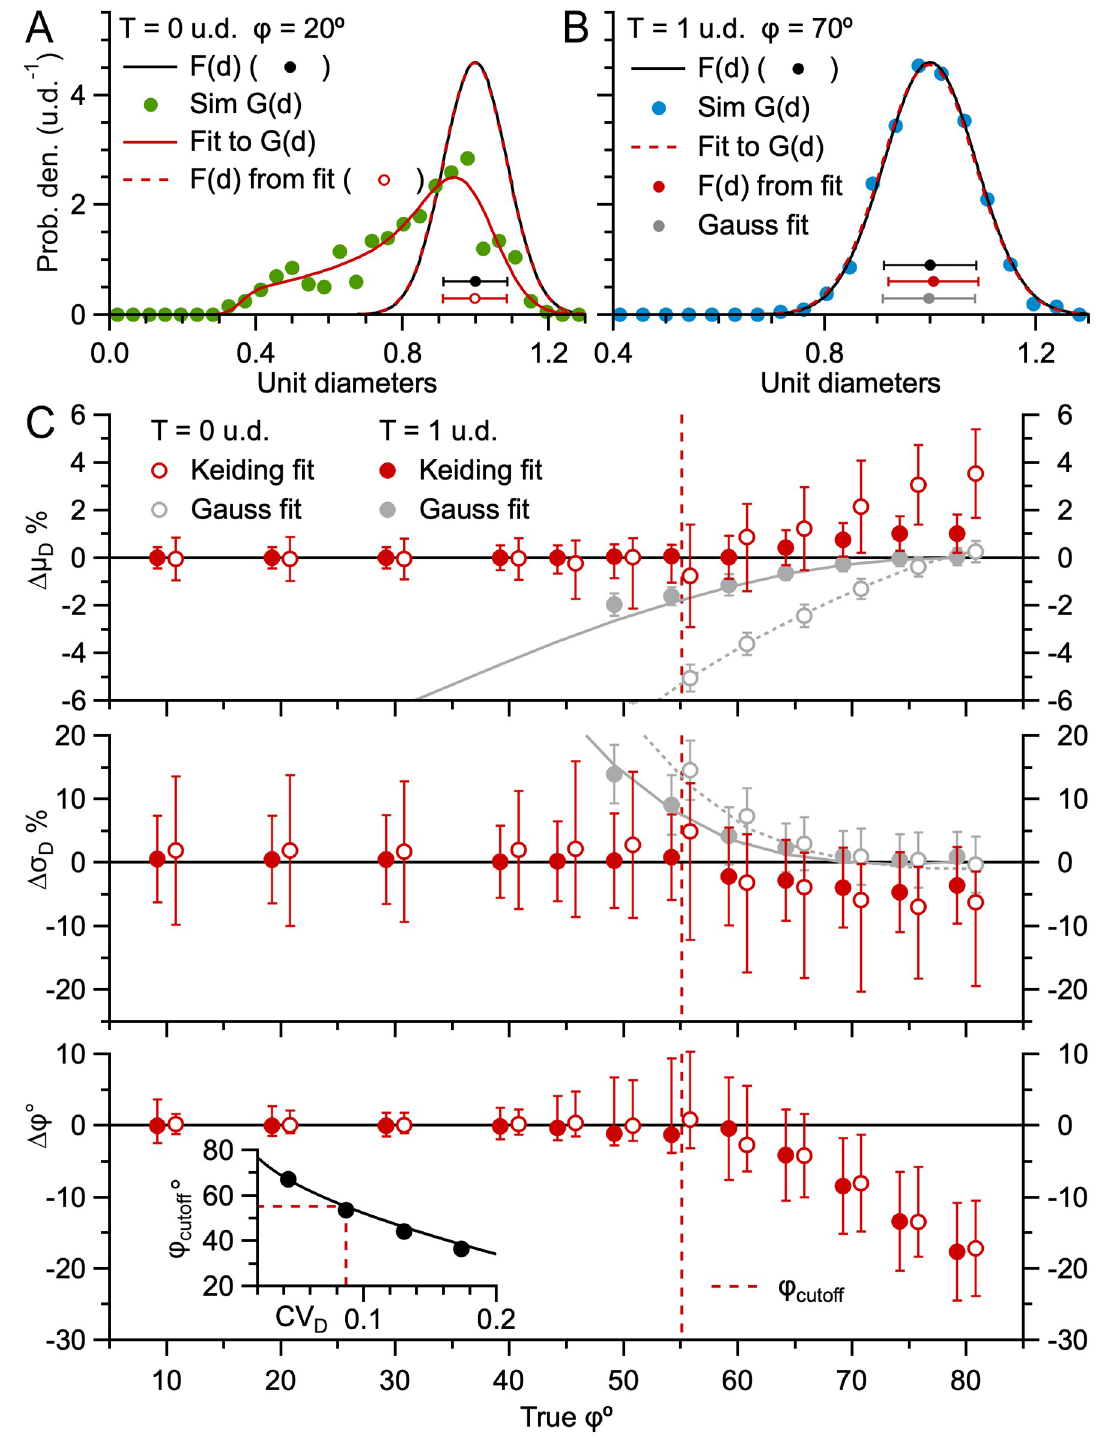
Fig 4. The Keiding model accurately estimates F(d) and ϕ from G(d) for true ϕ < ϕ cutoff (simulations). A. Curve fit of Eq 1 (red solid line) to G(d) of the simulation in Fig 3B where T = 0 u.d. and ϕ = 20˚ (green circles; ~500 diameters). F(d) derived from the fit (red dashed line and circle) matches the true simulation F(d) (black line and circle) and fit ϕ matches true ϕ ( Δ μ D = -0.1%, Δ σ D = +0.1%, Δ ϕ = +1˚). B. Same as A for G(d) of the simulation in Fig 3D where T = 1 u.d. and ϕ = 70˚ (blue circles). Although there is a good match between estimated and true F(d), estimation errors Δ μ D and Δ σ D are larger than those in A and estimated ϕ < true ϕ ( Δ μ D = +0.9%, Δ σ D